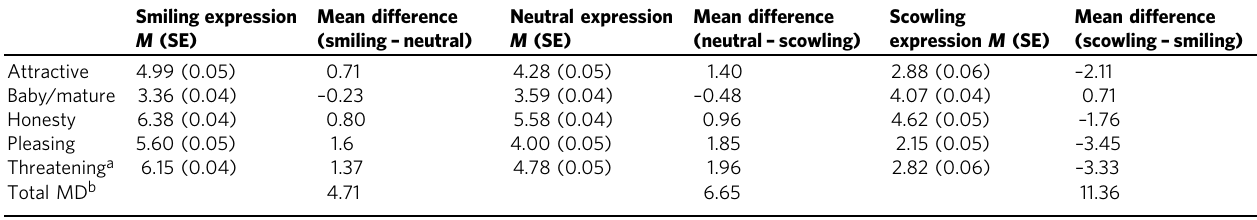
Table 2 Facial expressions and social perceptions, age and gender combined ( M , SE, and mean difference).